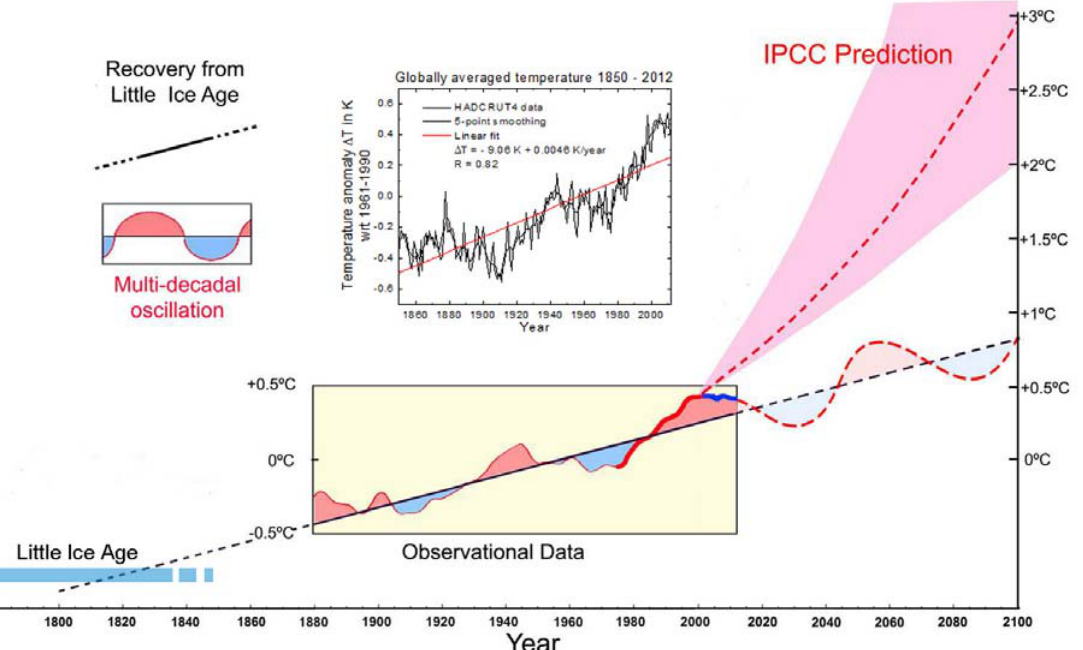
Figure 5. An interpretation of changes in global average temperature from 1800 to 2012. The temperature in the vertical axis is for reference scale; for detail, see the text. An insert above the yellow box is a detailed version of data shown in the yellow. The HadCRUT4 data are discussed by Morice et al .